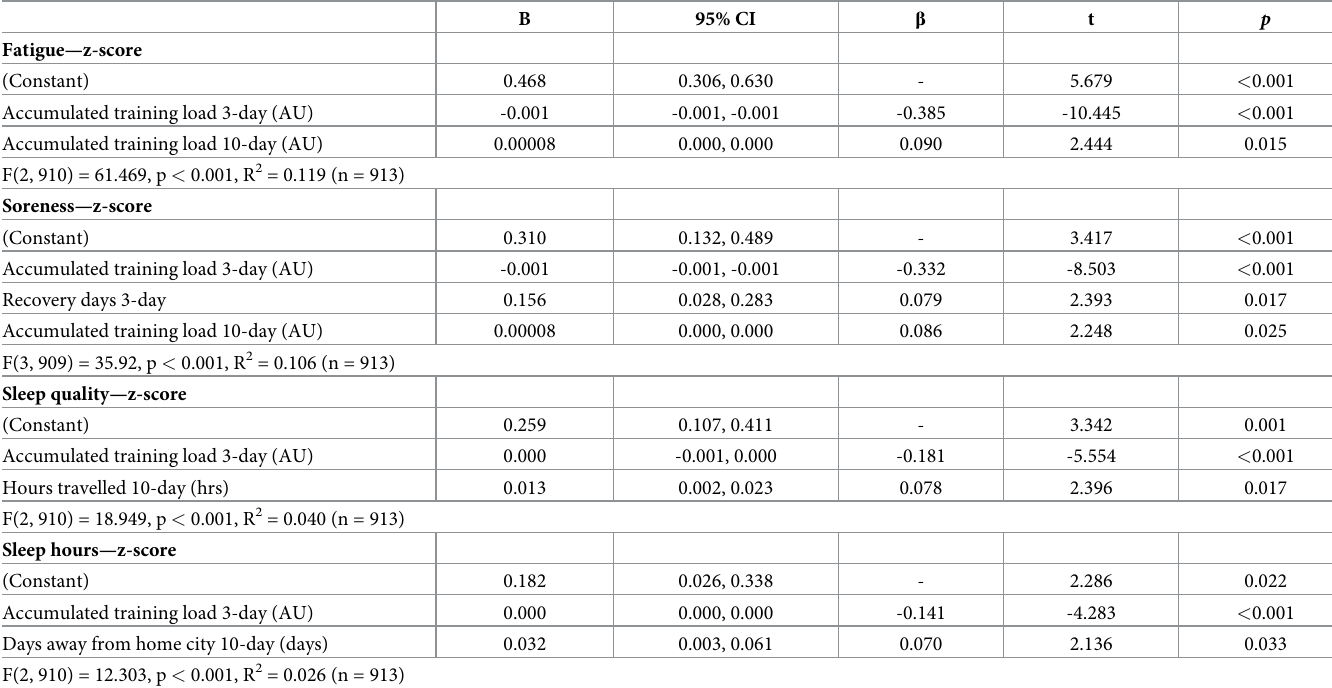
Table 5. Regression coefficients for estimating athlete-reported outcome measures during the season. B 95%